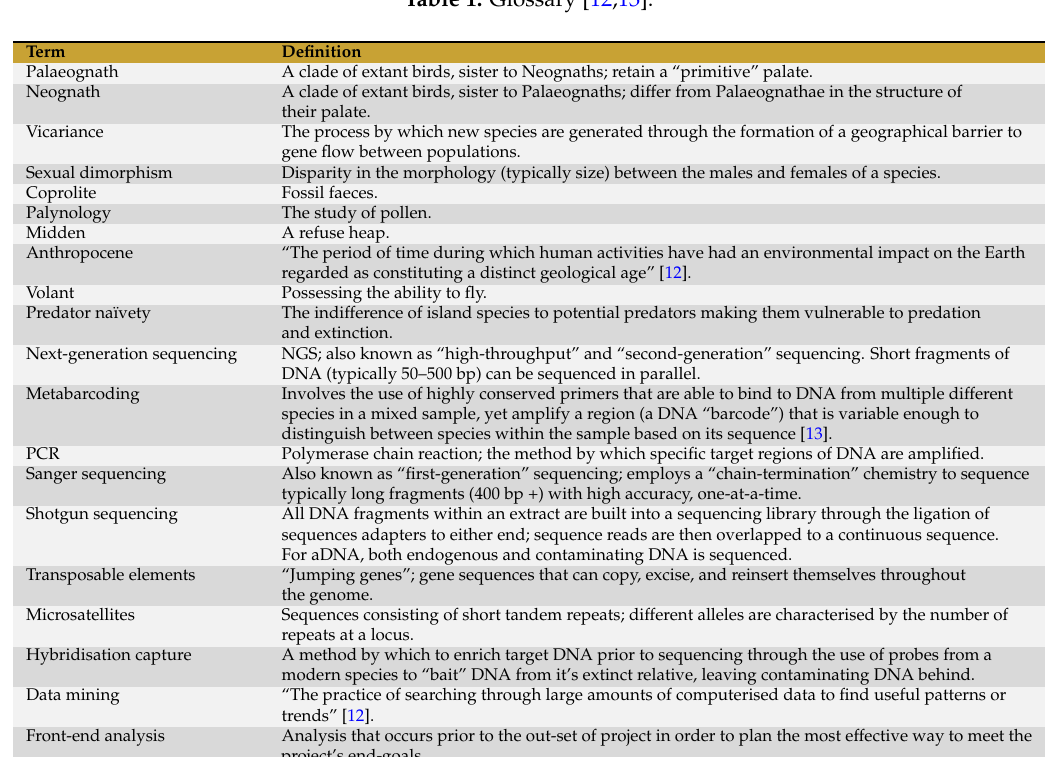
Table 1. Glossary